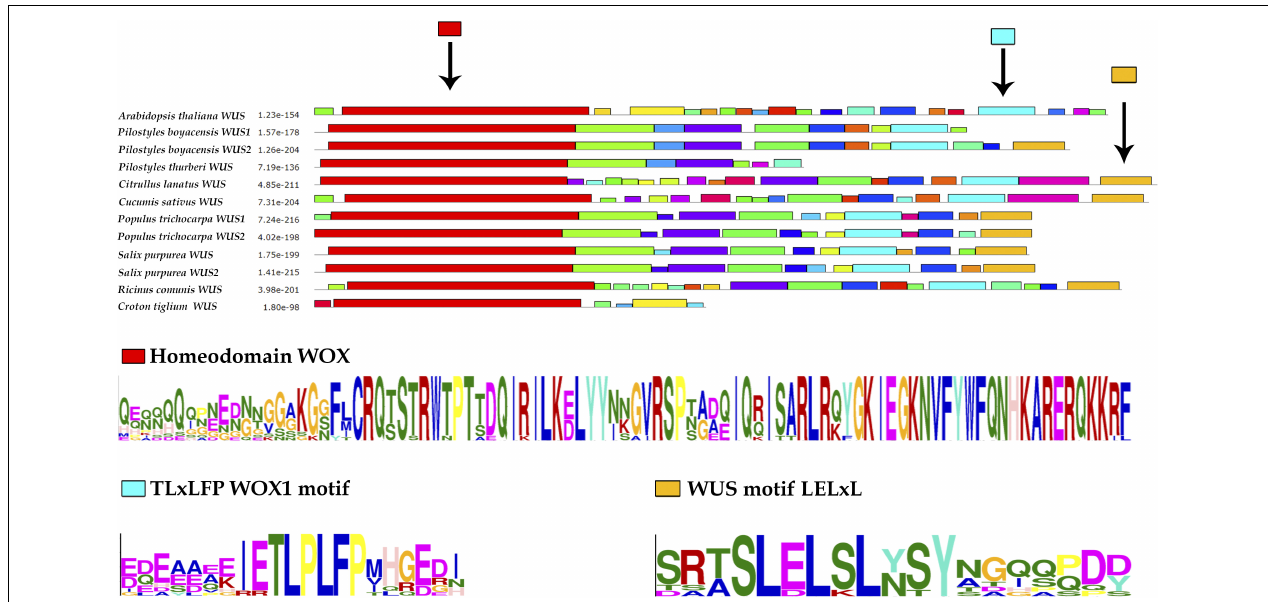
FIGURE 3 | MEME analysis of WUSCHEL proteins of A. thaliana , Apodanthaceae, Cucurbitaceae, Salicaceae, and Euphorbiaceae.